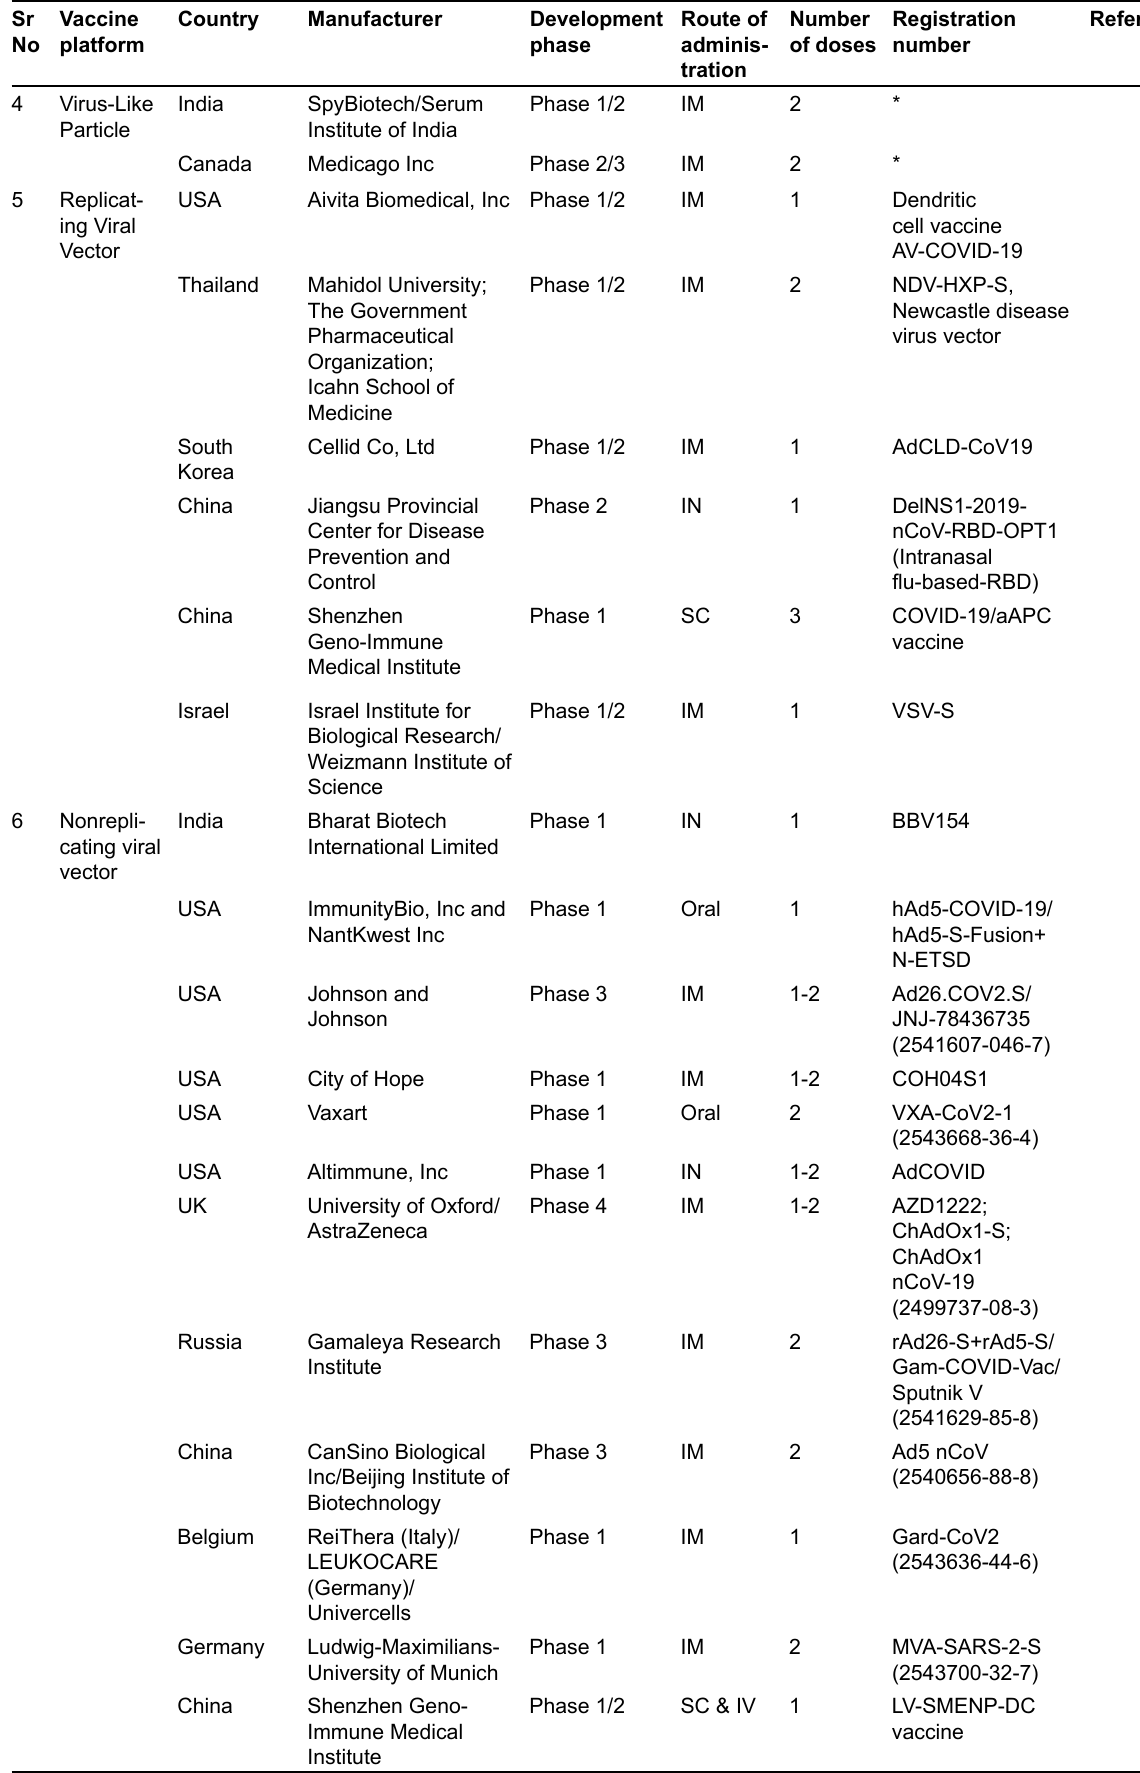
Table 2. Current development status of COVID-19 vaccine ( continued ) Sr